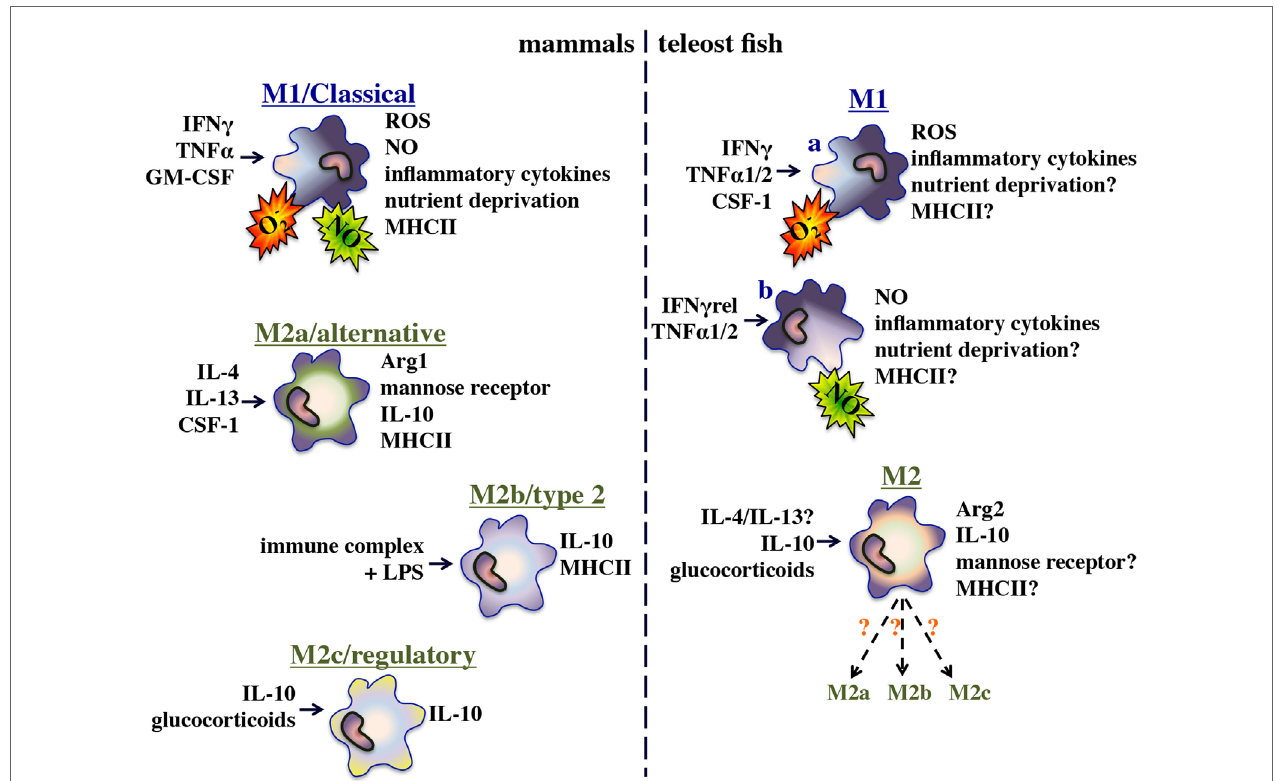
FigURe 1 | Functional polarization of mammalian and bony fish